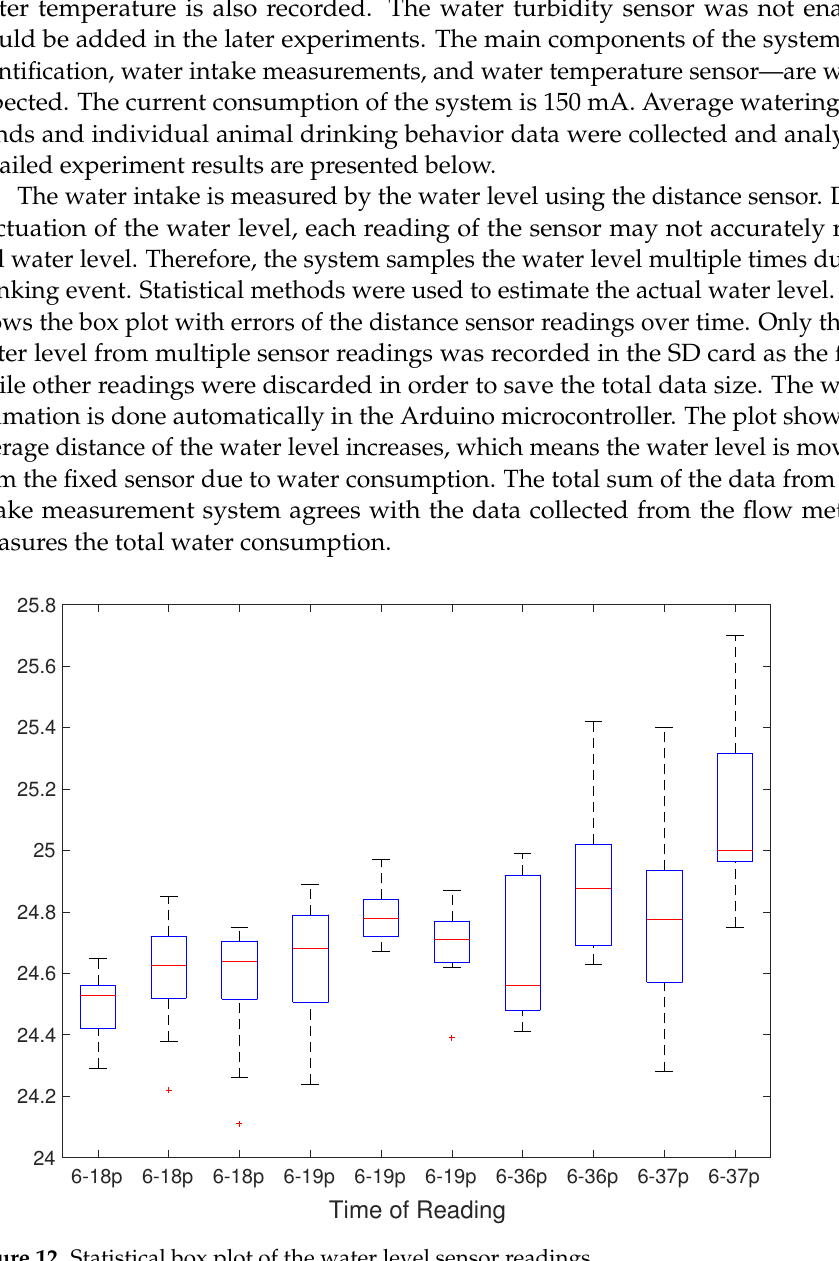
Figure 12. Statistical box plot of the water level sensor